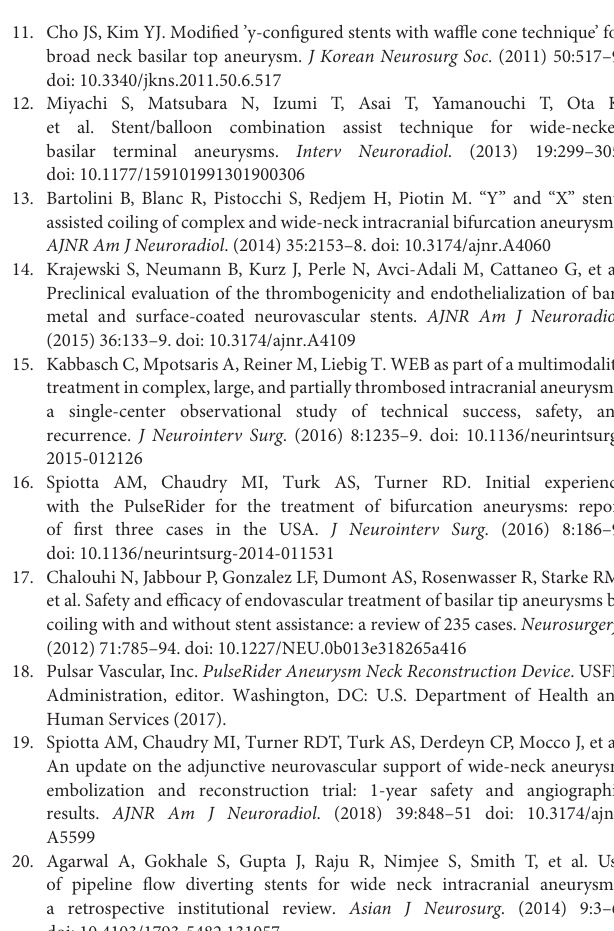
Supplemental Figure 1 | (A,B) Pre-op angiogram depicting the aneurysm and neck width. (C,D) Post-op depicting. Raymond 1 occlusion and restoration of native bifurcation branch angles after removal of